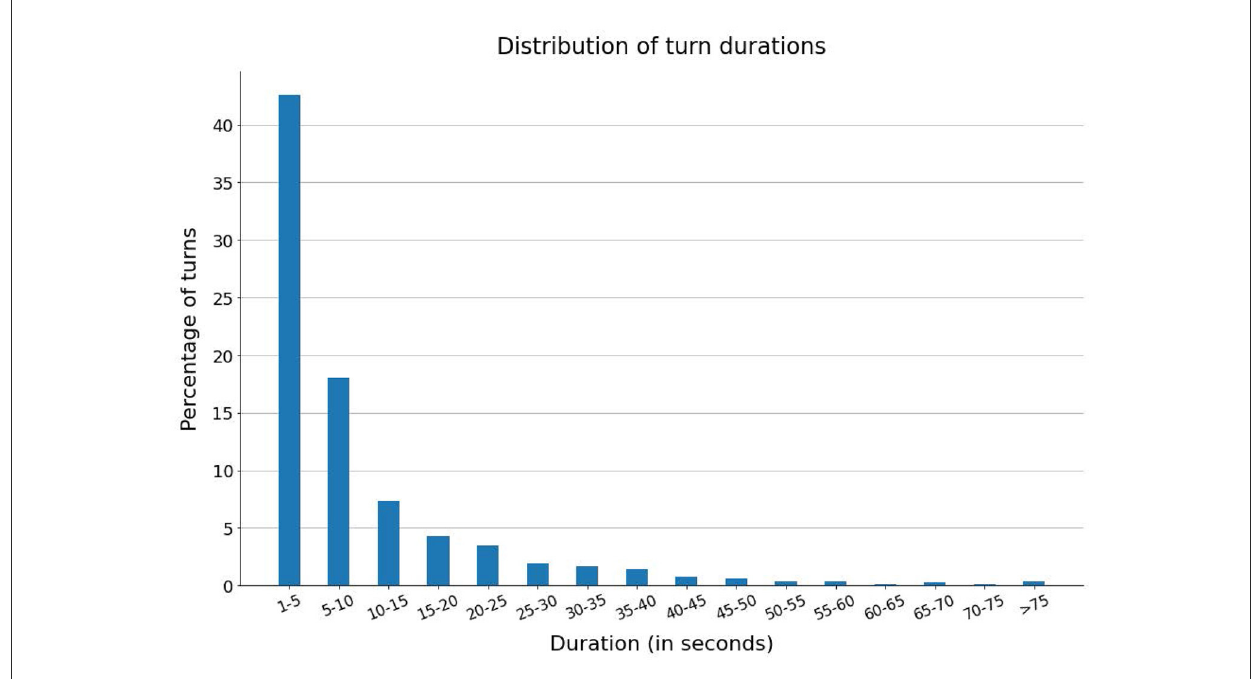
FIGURE1 Distribution of turn durations (in seconds) in the dataset.